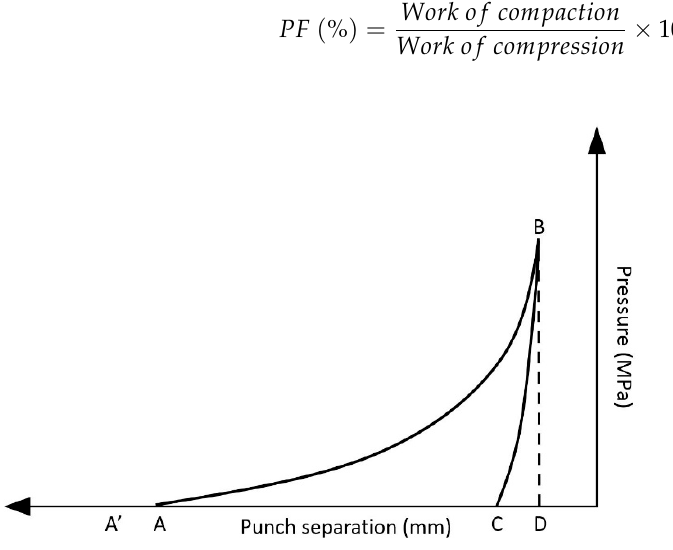
Figure 1. Force–displacement curve illustrating the different phases during compression.